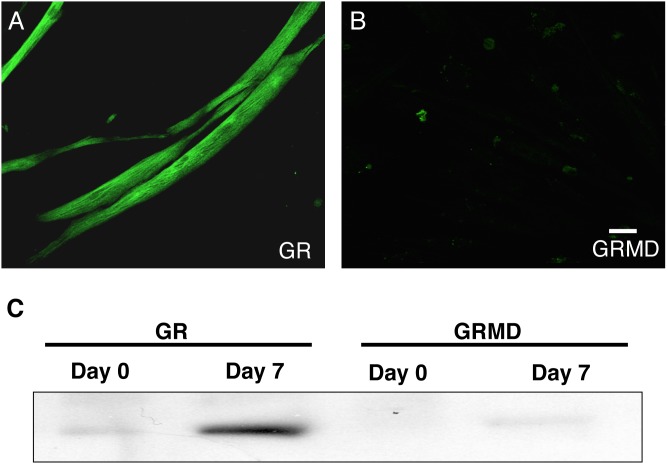
Dystrophin is absent in dystrophic ASM cells.Primary tracheal smooth muscle cells were grown to confluence from normal golden retriever (GR) (A) and golden retriever muscular dystrophy (GRMD) (B) animals and were serum starved in F12+ITS (1%) media to induce a contractile phenotype in culture. Cells were then stained for dystrophin (in green) and images were taken using a confocal laser scanning microscopy. Scale bar: 100 µm. Similarly western blotting was done for dystrophin (C) on primary tracheal smooth muscle cells from these animals at day 0 (proliferative phenotype) and day 7 (contractile phenotype). Results are representative of at least 6–9 in vitro experiments obtained from 3 different GR (normal) and GRMD (dystrophic) animals respectively.